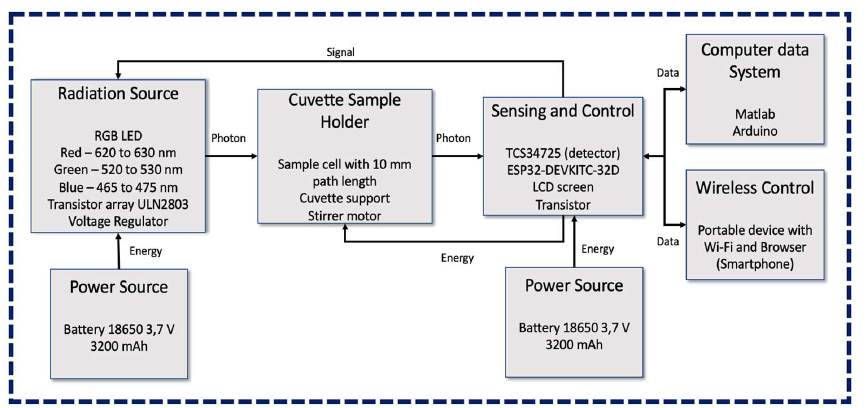
Figure 1. Block diagram presenting main components of IMS and representation of flow of light radiation, energy, data, and signal control through various domains in the instrument.